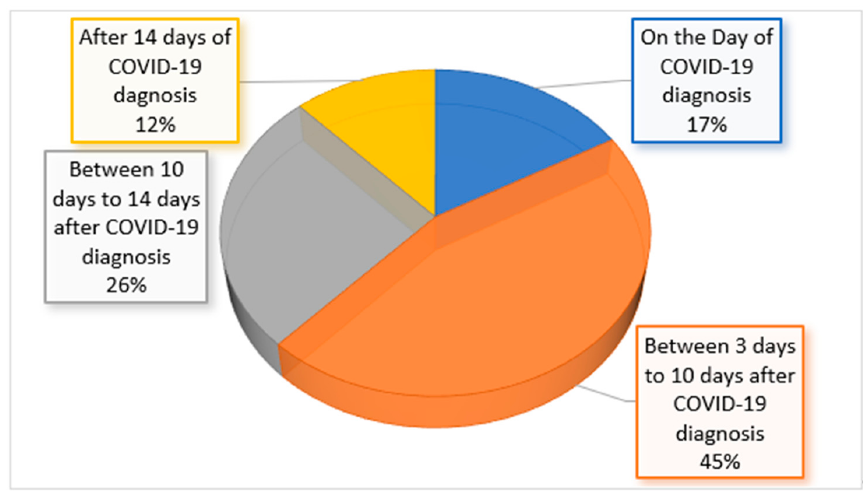
Figure 1. The onset of neurological symptoms among COVID-19 patients. Figure 2 distinguished the patients into three groups: people who had never smoked, former smokers, and current smokers. This depicts that 100% of patients who died were current smokers, followed by 75% of patients who died who were former smokers. Twenty-six percent of complete recoveries were observed in those patients who had never smoked.